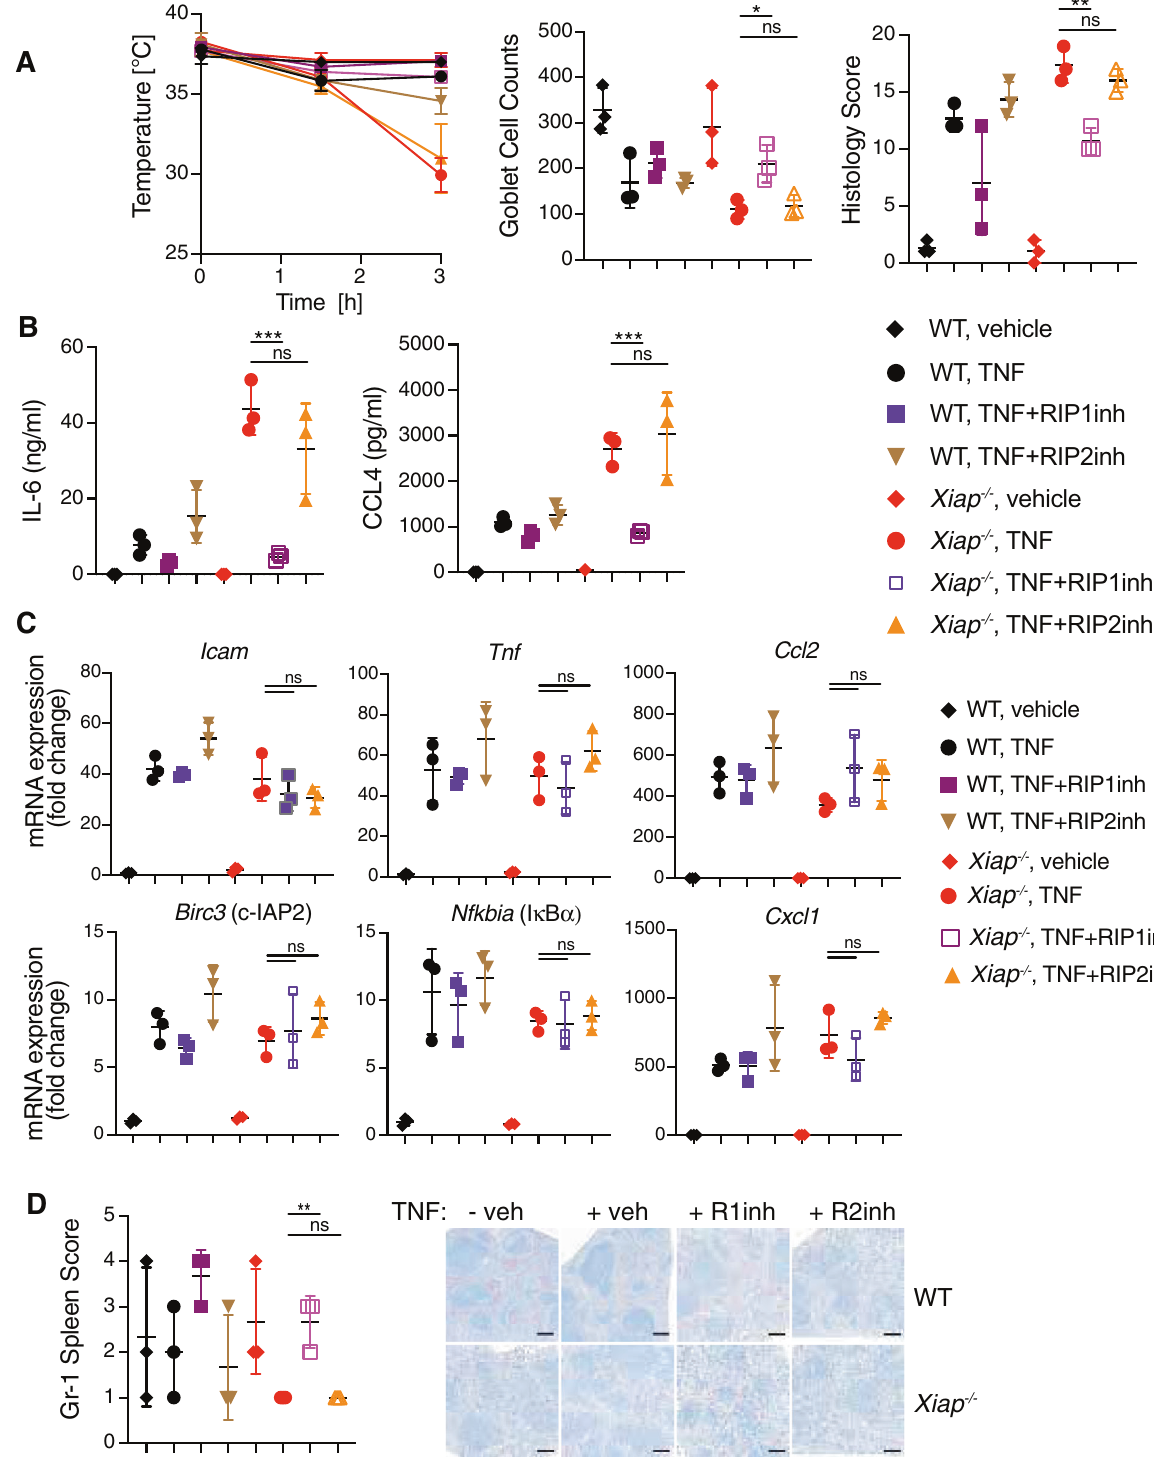
Western blot analysis For western blot analyses tissues were lysed in Triton or Urea buffers. Triton buffer: 1% Triton X-100, 25 mM Tris-HCl buffer (pH 7.5), 150 mM NaCl, 1 mM EDTA, Halt Protease and Phosphatase Inhibitor Cocktail (Thermo Scienti fi c). Cells were lysed on ice for 30 min and centrifuged at 14,000 rpm for 10 min at 4 °C [35]. 6 M urea containing buffer: 20 mM Tris – HCl pH 7.5, 135 mM NaCl, 1.5 mM MgCl 2 , 1 mM EGTA, 1% Triton X- 100, 6 M urea and Halt Protease and Phosphatase Inhibitor Cocktail